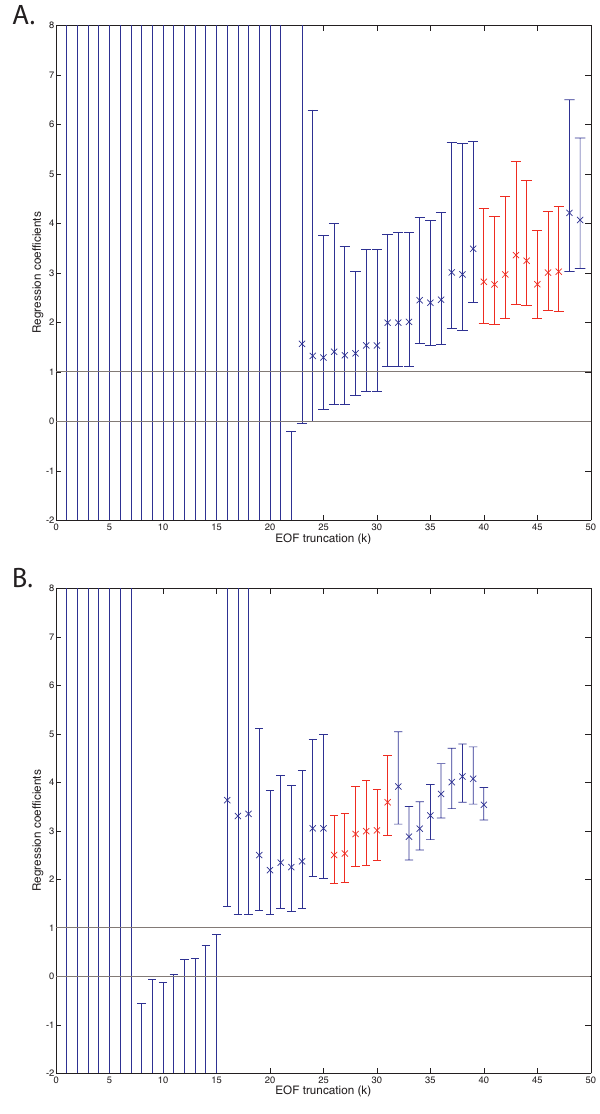
Fig. 9. Regression coefficients ( β ) and their 90% confidence intervals plotted as a function of EOF truncation ( k ) for 1-D MPI-ESM-LR (A) and HadGEM2-ES (B) optimal detection analyses. β estimates are relatively invariant where the residual consistency check passes (at k values shown in red).